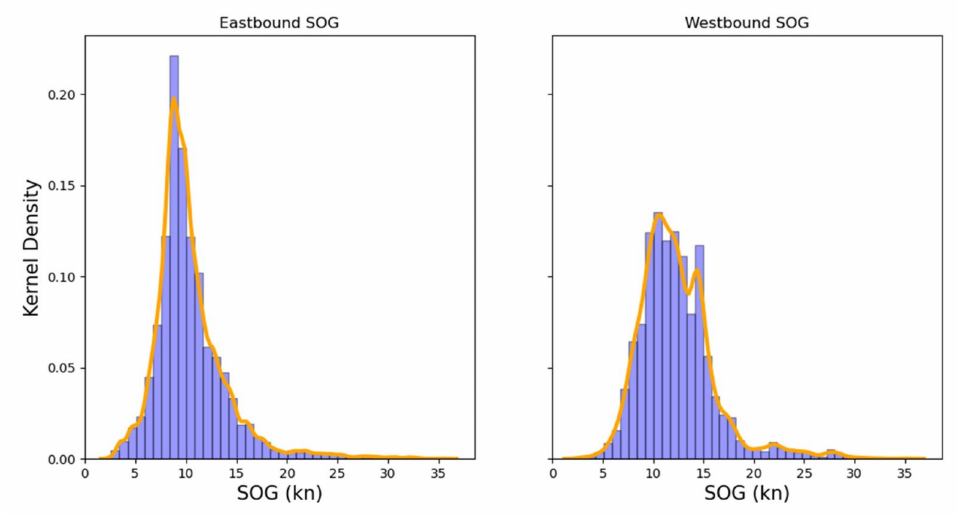
Figure 11. Histogram and PDF for SOG in the selected cell of the